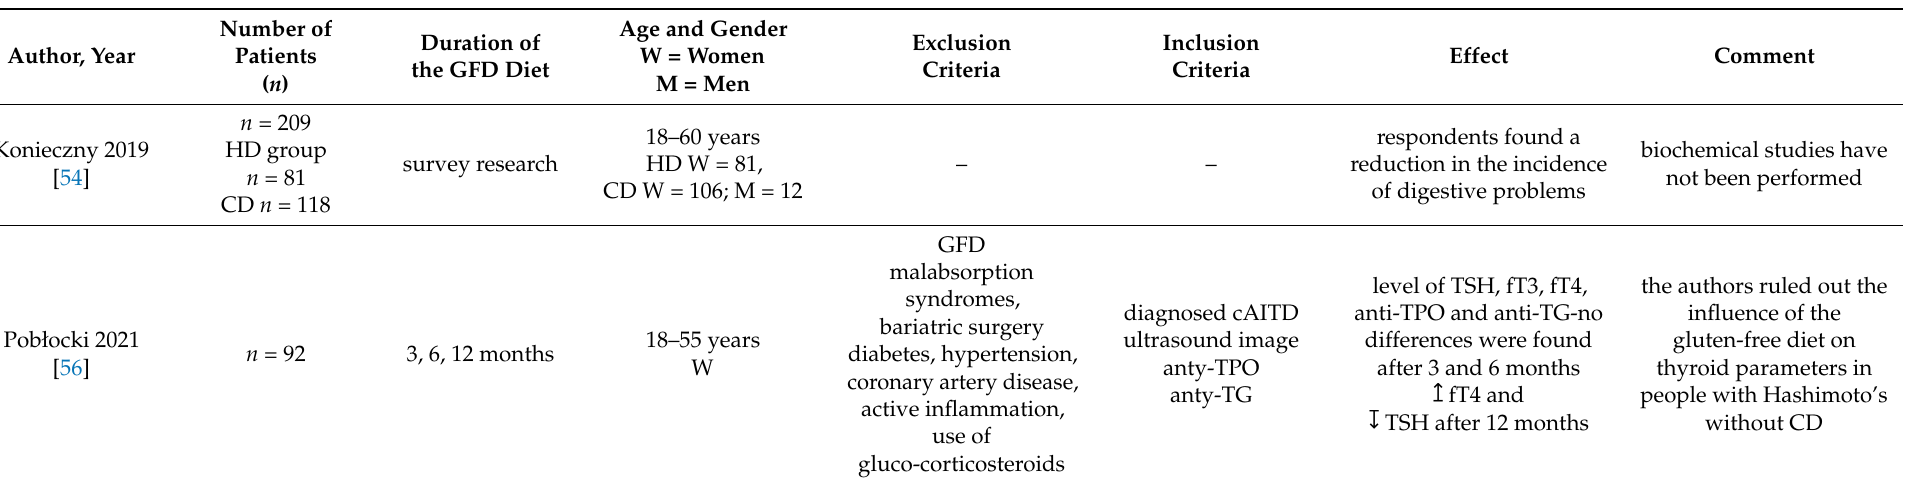
Table 155: fdsymbol Negated Arrows